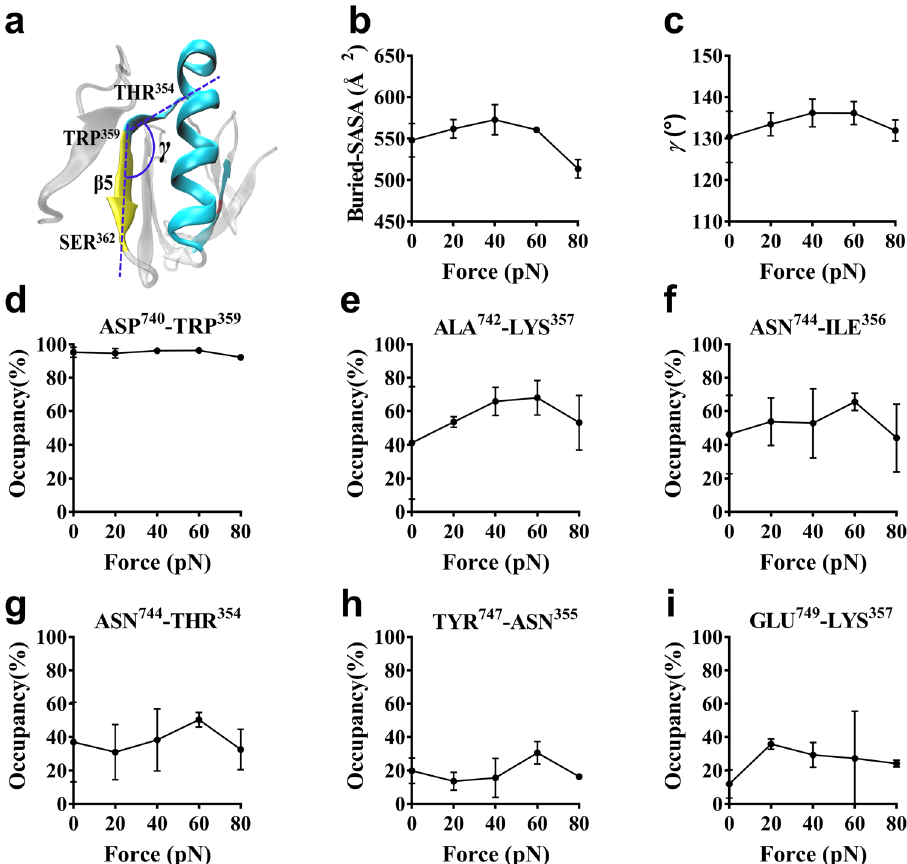
Figure 7. Force regulation mechanism of the interaction between β3 integrin and Talin F3. ( a ) Schematic diagram for β5 strand in Talin F3 domain. The turn angle γ of β5 strand were estimated herein by the cross angle of two lines, which linked two Cα-atoms either in both ALA 360 and SER 362 (yellow) or in both TRP 359 and THR 354 (cyan). ( b ) Variation of the mean buried SASA versus tensile force. ( c ) Plots of the turn angle γ against tensile force. ( d ) ASP 740 with TRP 359 , ( e ) ALA 742 with LYS 357 , ( f ) ASN 744 with THR 356 , ( g ) ASN 744 with ILE 354 , ( h ) TYR 747 with ASN 355 , and ( i ) GLU 749 with LYS 357 . All data from 40 ns runs thrice were shown in mean ±